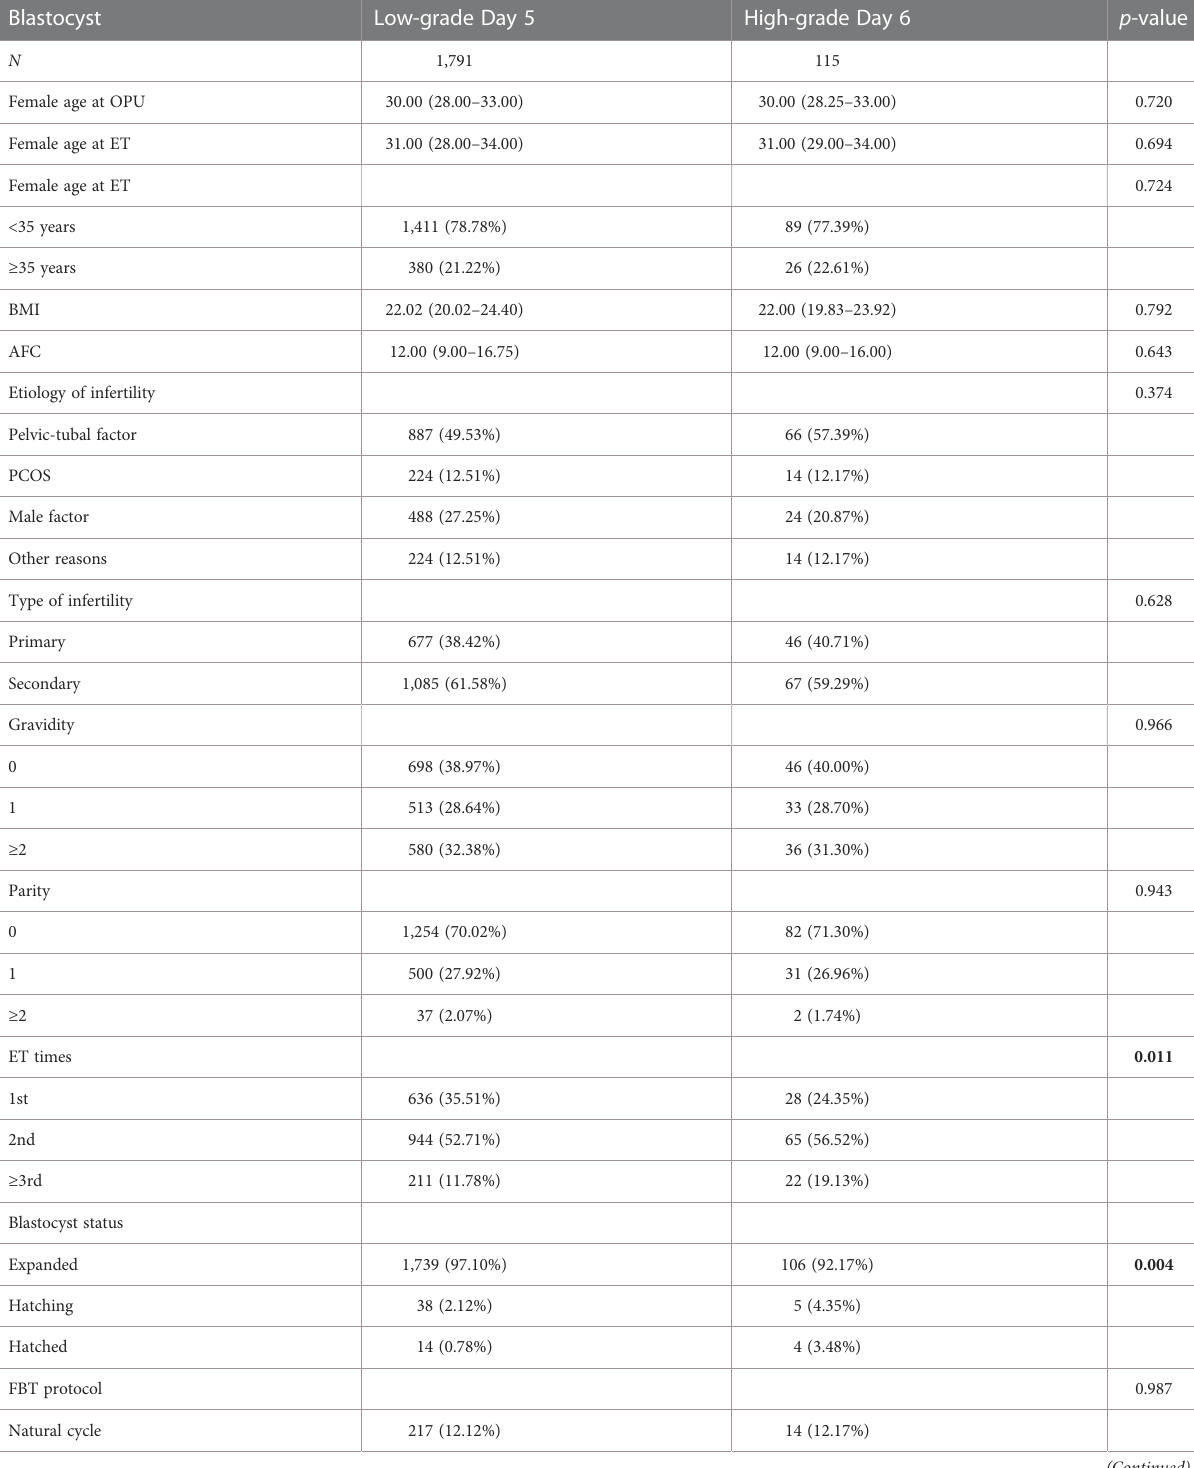
TABLE 1 Patient and cycle characteristics according to blastocyst day and morphology